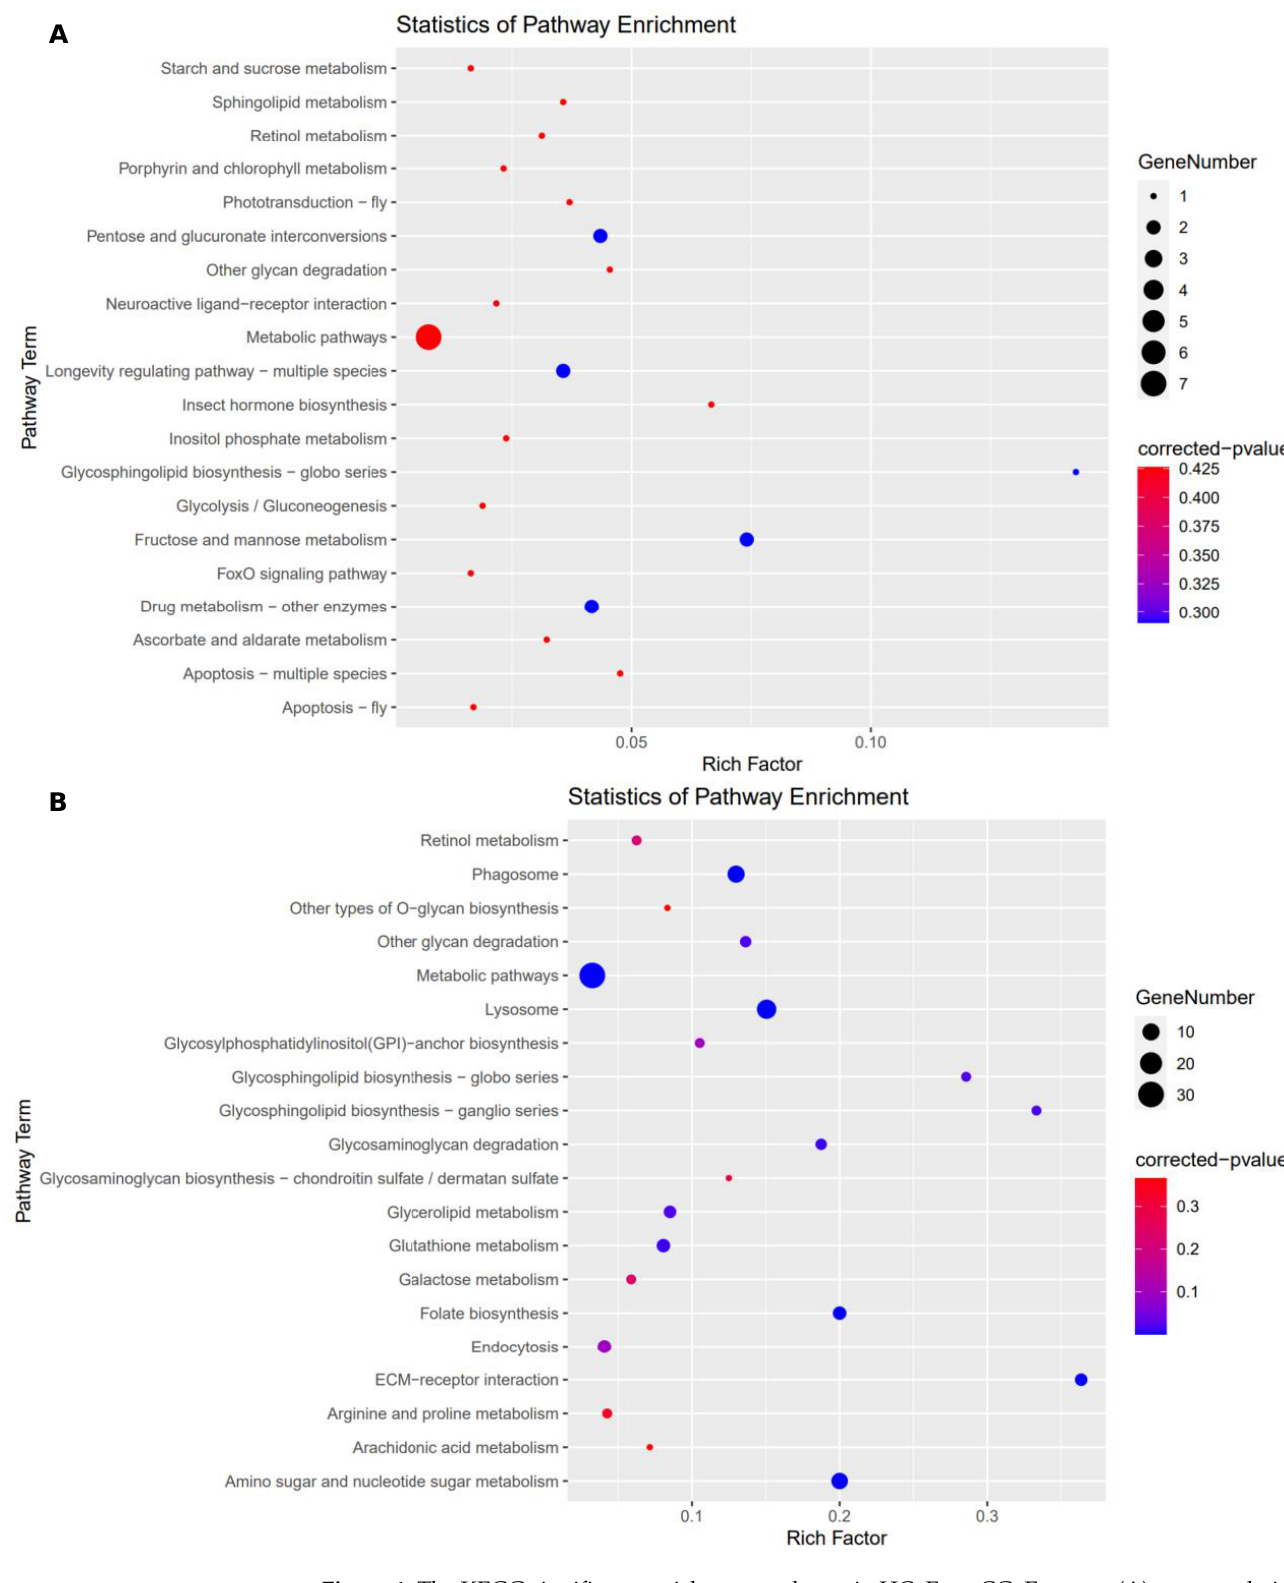
Figure 4. The KEGG significant enrichment pathway in HC_E vs. CG_E group. ( A ) up − regulation pathways in HC_E vs. CG_E group; ( B ) down − regulation pathways in HC_E vs. CG_E group.